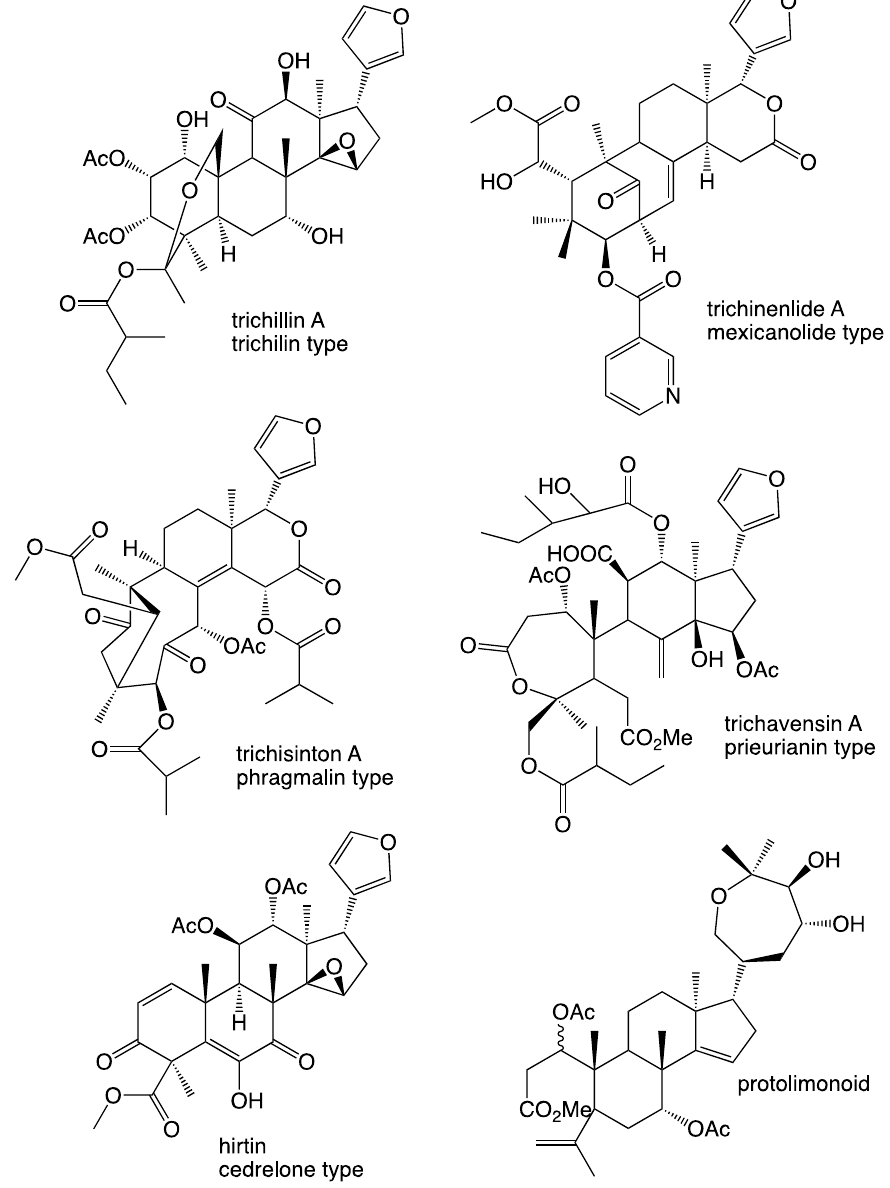
Figure 1. Limonoids isolated from other Trichilia species.